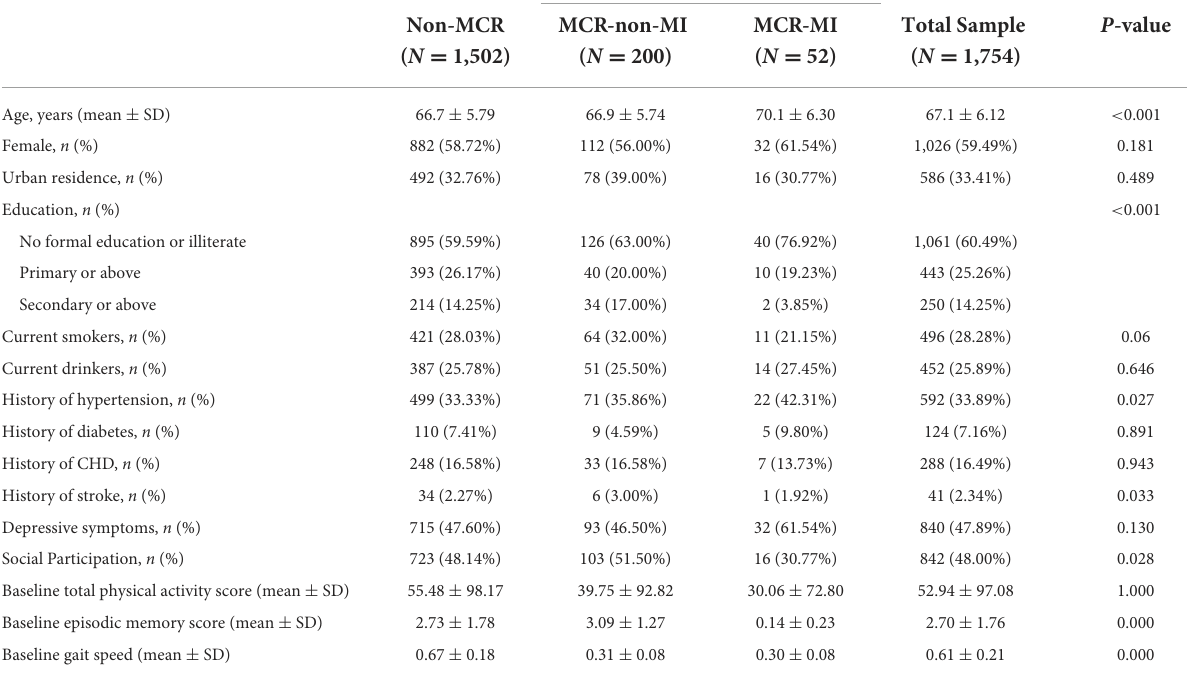
TABLE 1 Characteristics of study participants for ADL disability analysis ( N =